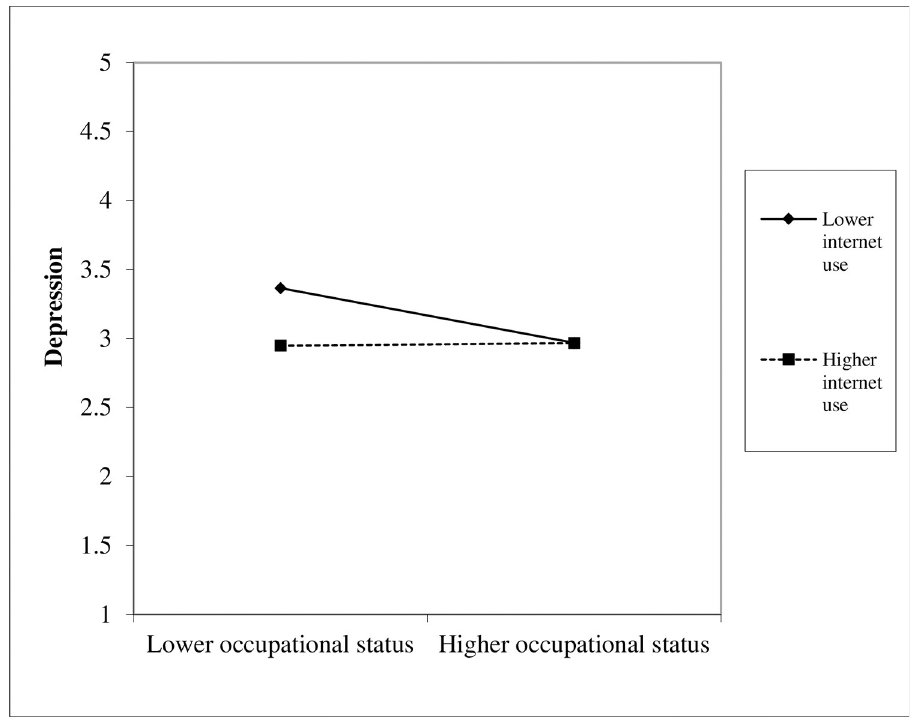
Fig 2. Moderating effect of internet use.